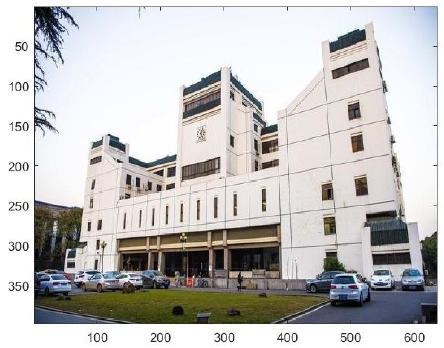
Figure 6. Analysis of landscape